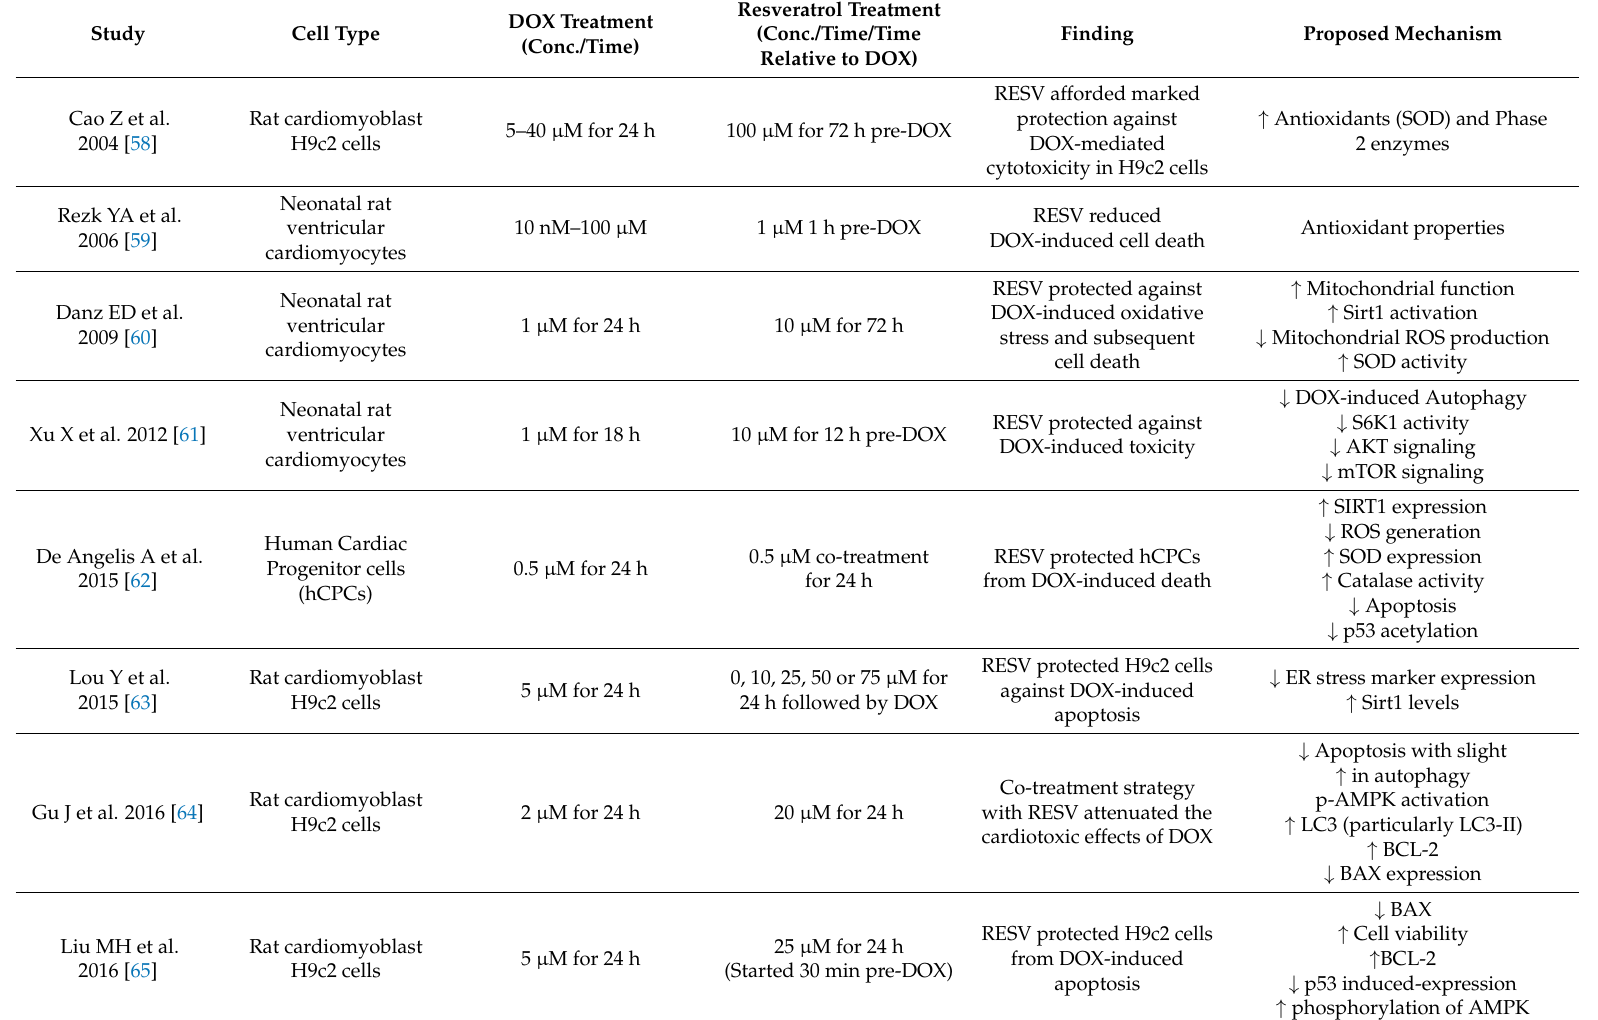
Table 1. In vitro studies demonstrating the cardio-protective effects of resveratrol against anthracycline-induced